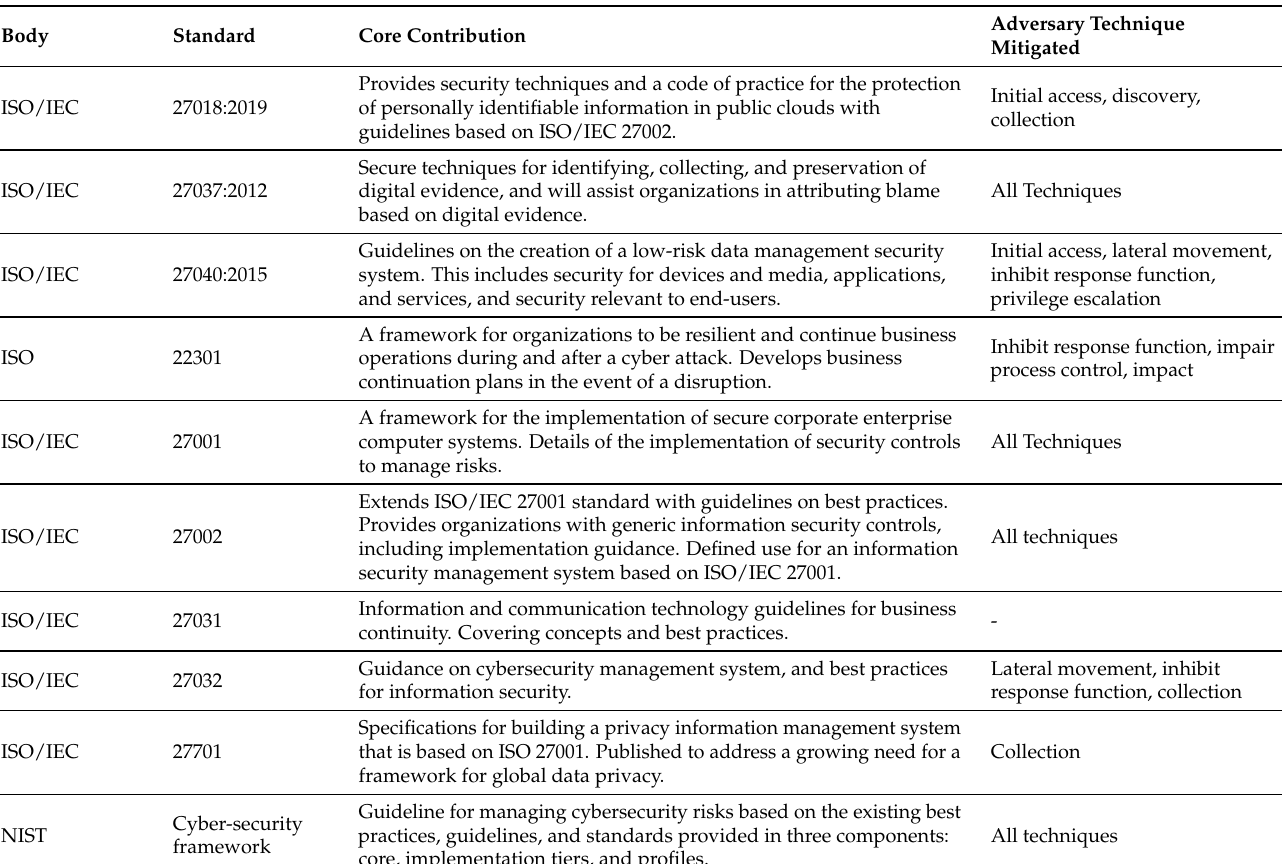
Table 3. Standards that govern the frameworks, best practices, and specifications for cybersecure information